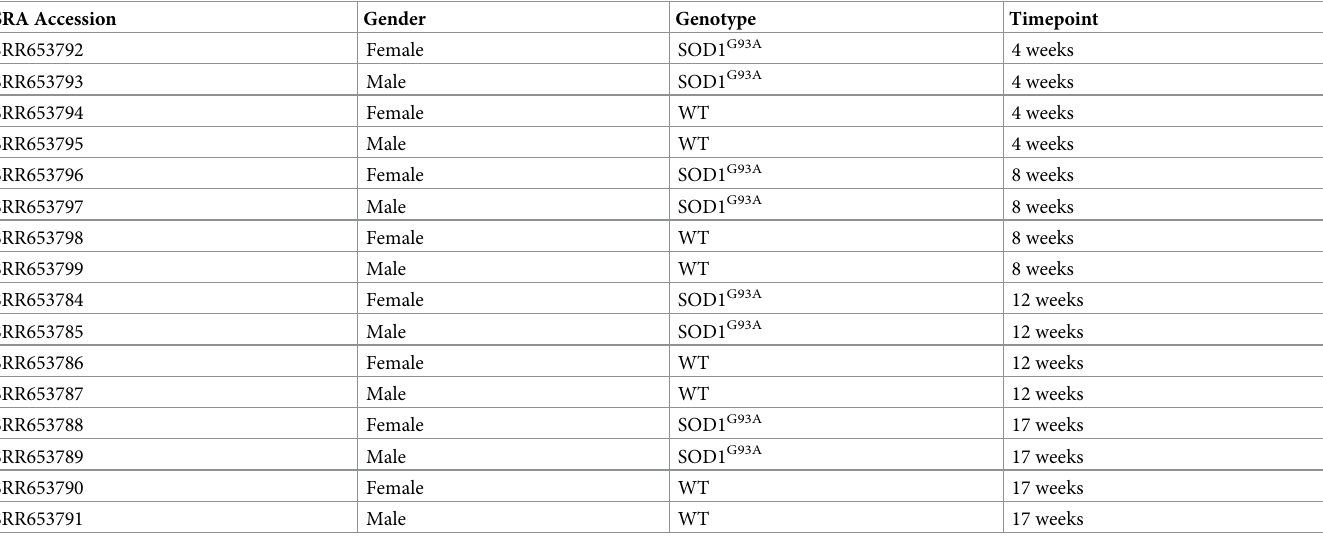
Table 1. Sample description of the RNA-Seq datasets used in our work, published by Phatnani et al (2013). SRA Accession Gender Genotype Timepoint Female SOD1 G93A 4